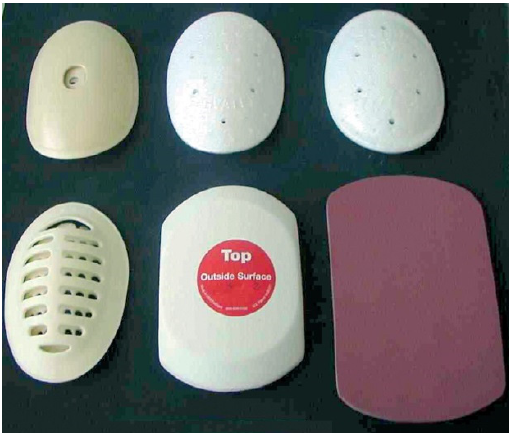
Figure 1. The currently common ‐ used hip protectors for seniors.